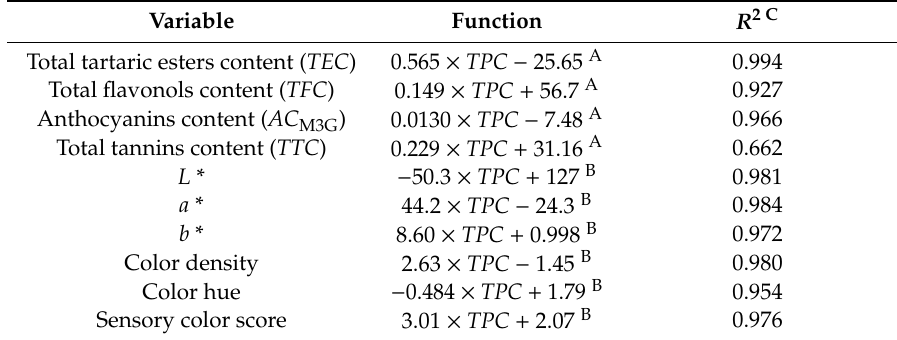
Figure 3. Principal component analysis (PCA) biplots for chemical compositions, CIE colorimetric parameters, and sensory attributes of four red wines. Samples are explained in Table 2. Table 4. Changes in various phenolic compositions, colorimetric parameters, and sensory color score of four red wines studies with respect to total phenolics content ( TPC